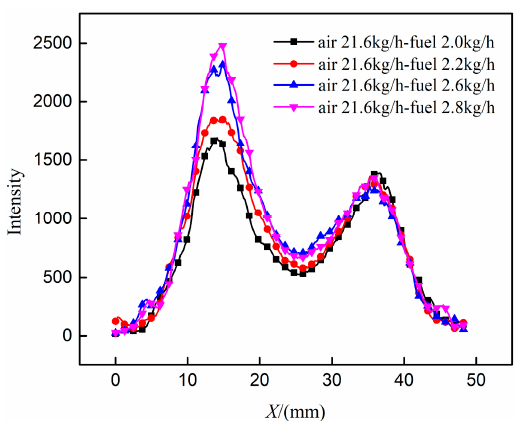
Figure 20. The influence of fuel mass rate on fuel distribution at a distance of 15 mm from the swirler exit in the y -direction (Case B).